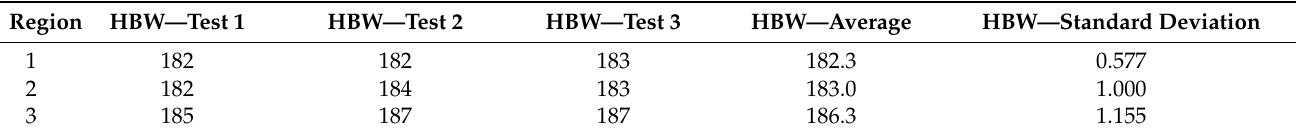
Table 2. Brinell hardness [33] measured in the regions of the axle defined in Figure 2.